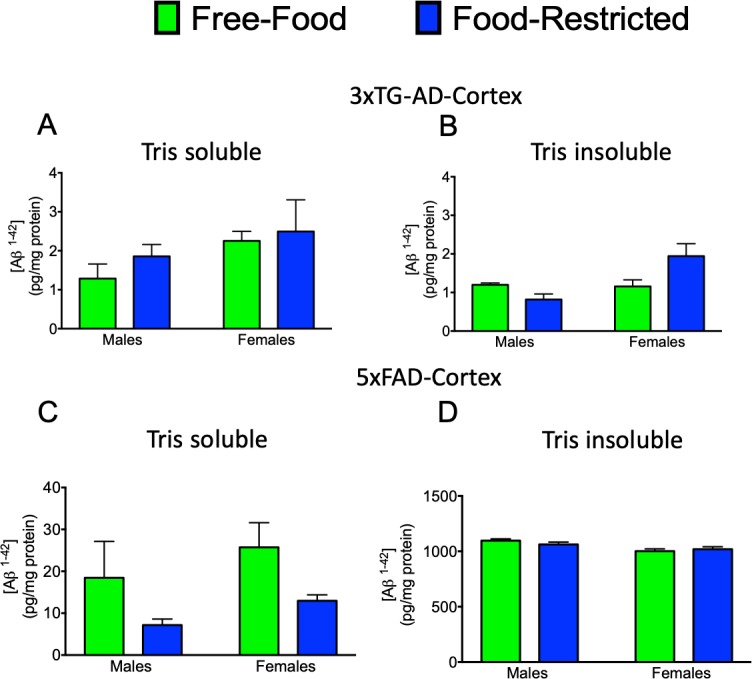
The effect of mild caloric restriction on Aβ(1–42) levels in male and female 3xTG and 5xFAD mice at 6 months of age.(A) 3xTG Tris-soluble (p=0.921 for males and 0.999 for females); (B) 3xTG-AD Tris-insoluble (p=0.965 for males and 0.1512 for females); (C) 5xFAD Tris-soluble (p=0.163 for males and 0.367 for females); (D) 5xFAD Tris-insoluble (p=0.8271 for males and 0.991 for females);. At least three extracts obtained from each genotype/sex were analysed by Aβ(1–42) ELISA kit.